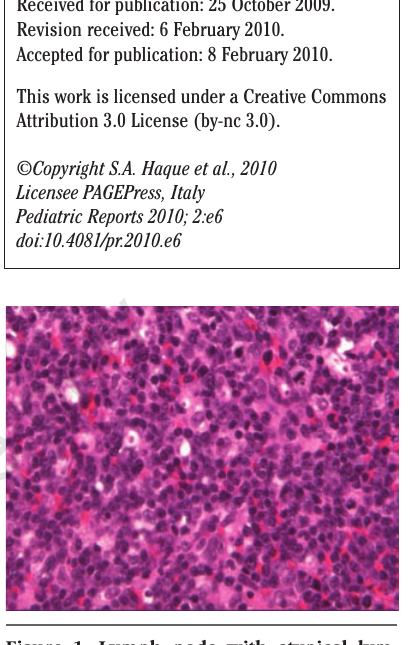
Figure 1. Lymph node with atypical lym- phoid cells.